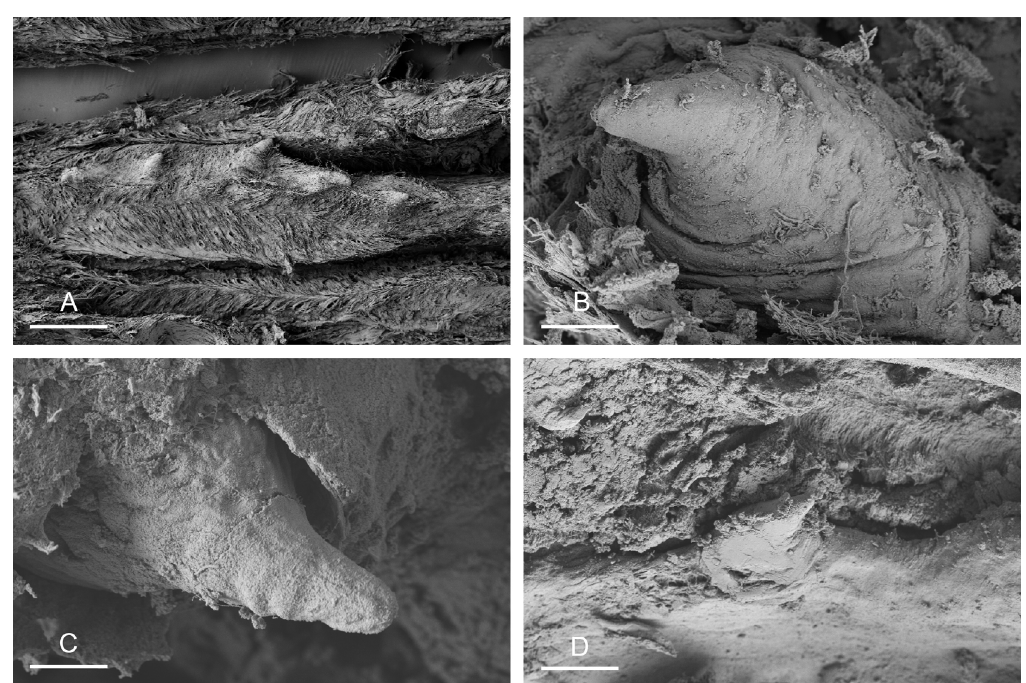
Fig. 21. Paromoionchis tumidus (Semper, 1880) comb. nov. unit #1, penial hooks. A . Indonesia, Sulawesi [2240] (UMIZ 00125). B . Indonesia, Ambon [2832] (UMIZ 00129). C . Lectotype of Onchidium mertoni Simroth, 1918 (ZMB 121591a). D . Lectotype of Onchidium tumidum (ZMB 39019a). Scales: